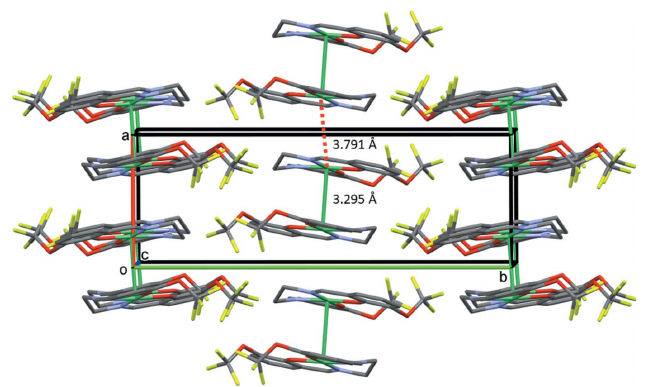
Figure 2 A view along the c axis of the crystal packing of the title compound. The